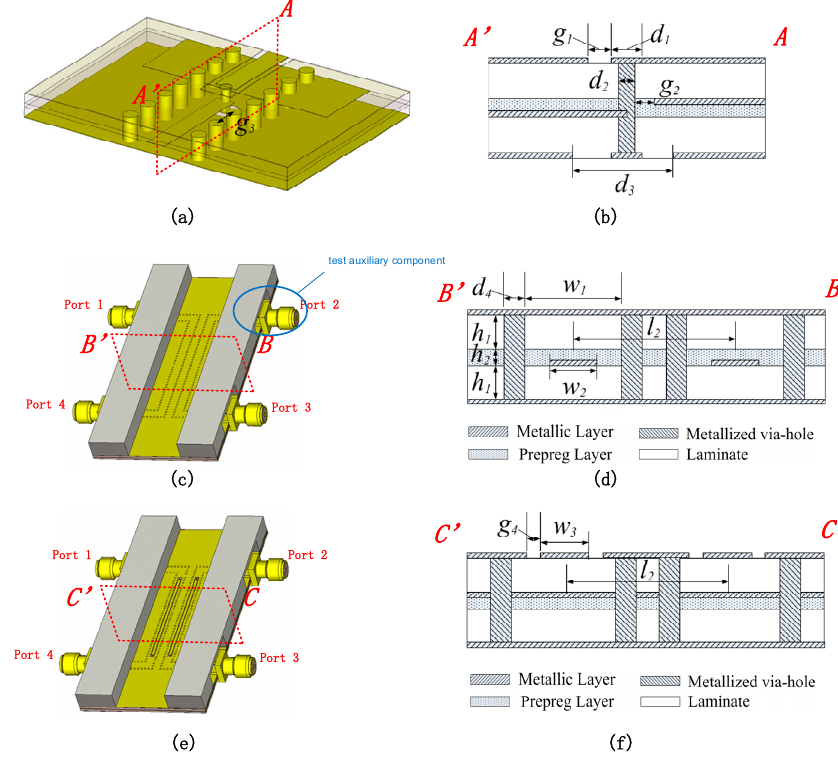
Figure 3. The 3D model ( a ) and cross-section ( b ) of the SICL-GCPW transition. 3D model ( c ) and cross-section ( d ) of the parallel coupling line of SICL-TS. 3D model ( e ) and cross-section ( f ) of the parallel coupling line of GCPW-TS.